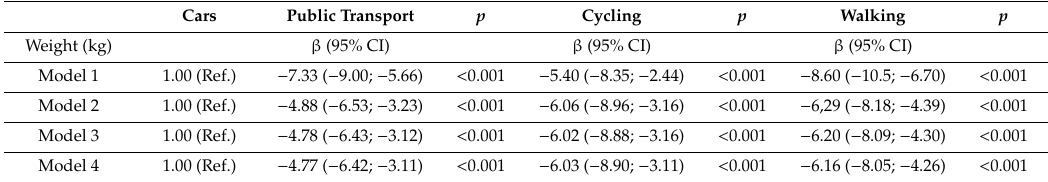
Table 2. Associations between travelling mode and adiposity